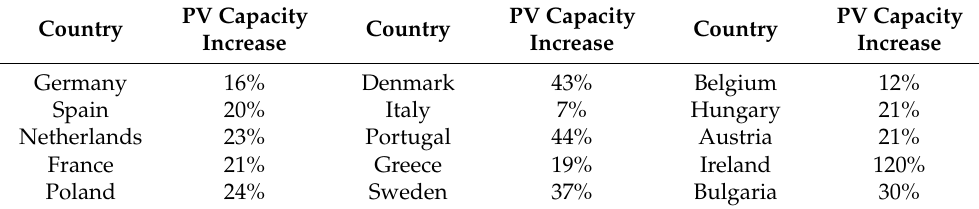
Table 3. Annual PV capacity increase in selected European